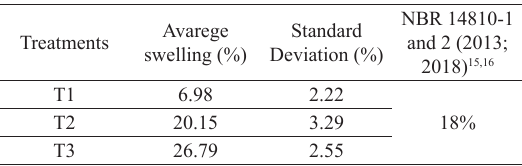
Table 2. Table of average density, highest percent density change and value required by the standard. Treatments